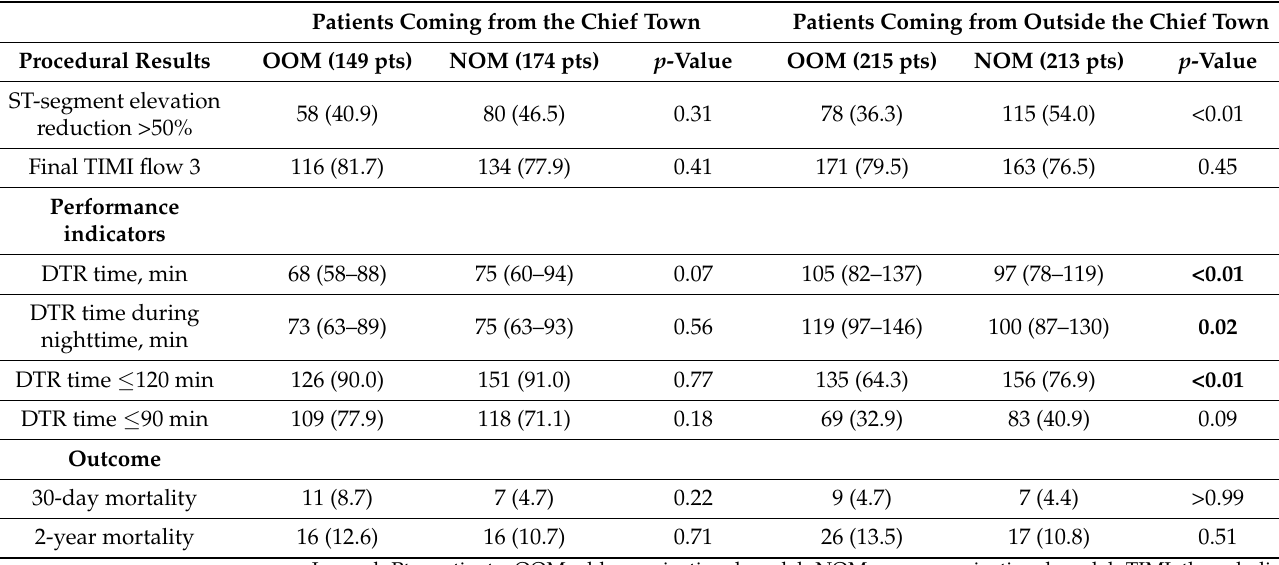
Table 2. Procedural results and performance indicators according to the two different territorial areas in the old and in the new organizational